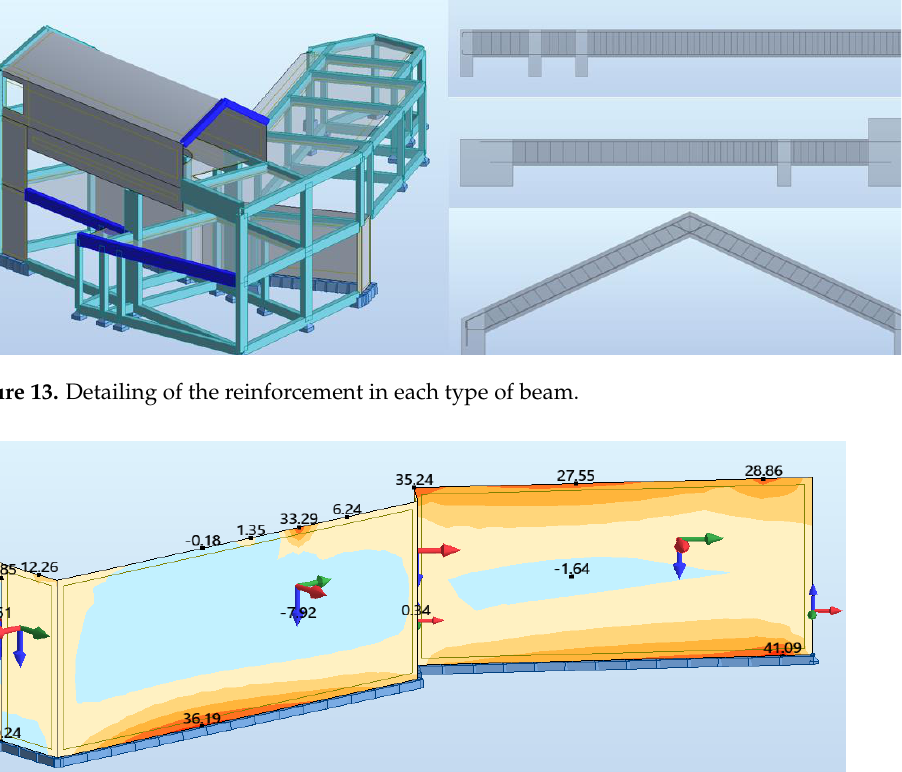
Figure 14. Efforts on the basis of the retaining walls. 4.3. Phase 3: Transfer of Analysis Results The analysis of the interoperability capability between Revit and Robot (2022 ver- sions) regarding the reverse transfer process, Robot/Revit, where there is usually a greater limitation, is evaluated in this item. On each type of element, the identified inconsistencies were analyzed and a possible resolution strategy was presented in order to overcome the difficulties found. The lack of interoperability demonstrated between the softwares led to the option of replicating some procedures, to “ unite ” the two models again. A general update was then performed on the Revit model, where most of the elements had to be adjusted, and then the Revit/Robot transfer was performed for the structural calculation. Afterward, the update operation of the Revit model was performed again, and, in the transfer process, there were no longer any warnings regarding significantly different models: •